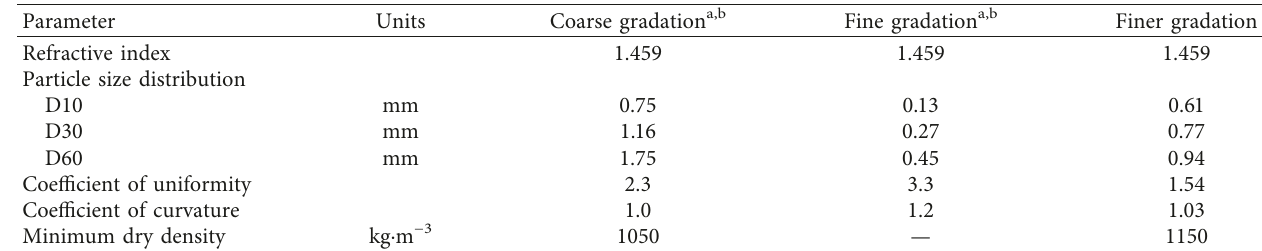
Figure 2: Particle size distribution curve. Table 1: Transparent soil properties.